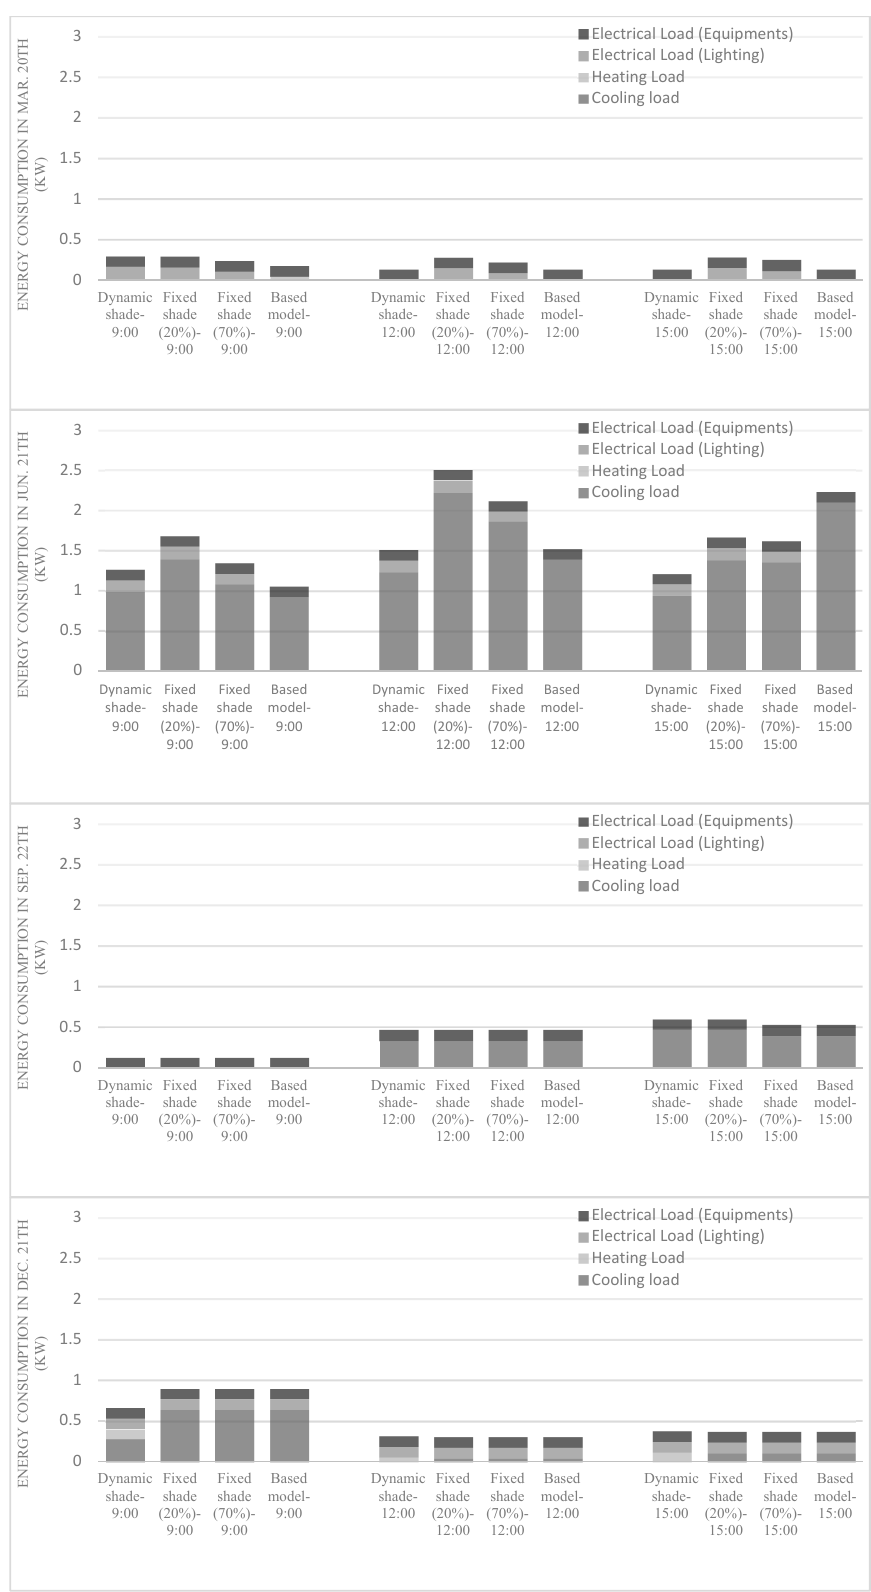
Figure 17. Energy consumption of the building with each shading device in studied dates and hours. Comparative